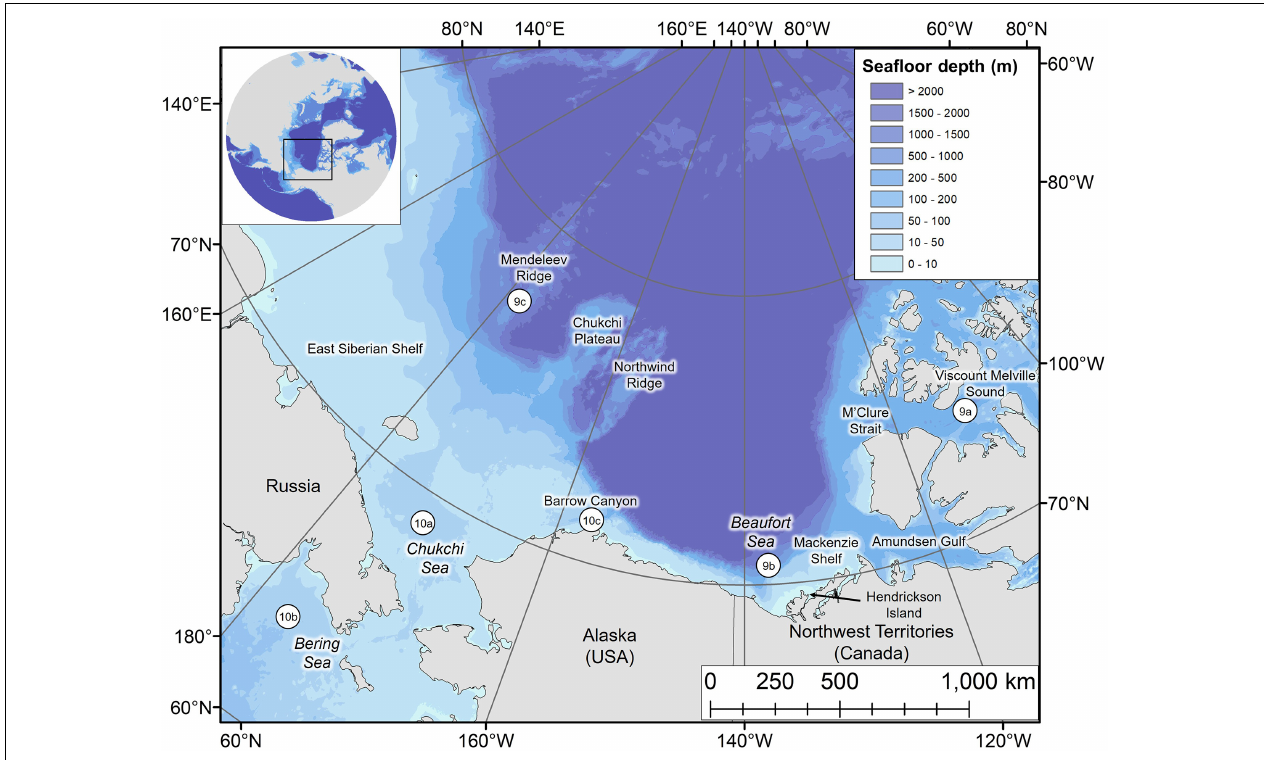
FIGURE 1 | Map of the study area with key locations labeled. Numbered circles 9a–9c and 10a–10c denote the locations of dive profiles shown in Figures 9 , 10 , respectively.